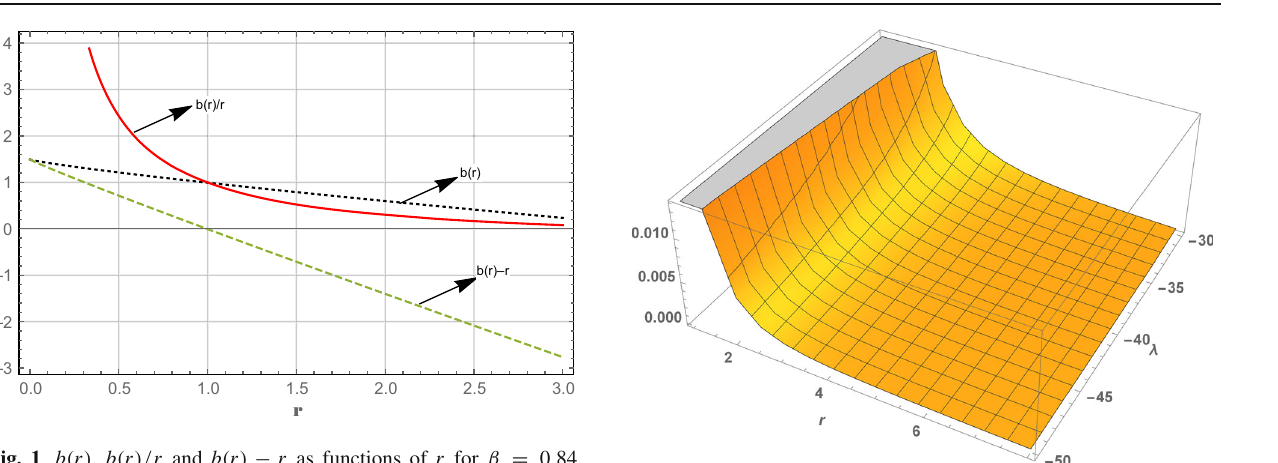
Fig. 1 b ( r ) , b ( r )/ r and b ( r ) − r as functions of r for β = 0 . 84, a = − 0 . 5 and r 0 = 0 . 995